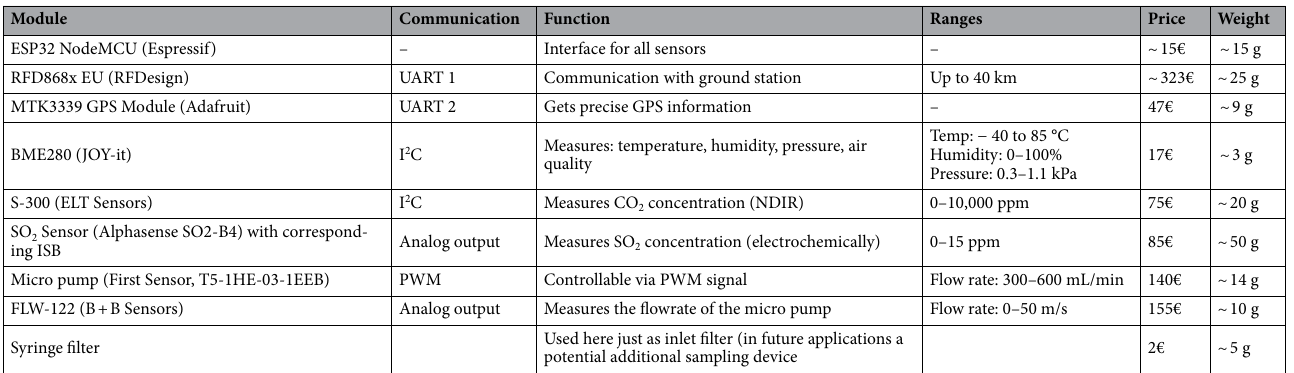
Table 1. Parts list of the sensor system with type of data transmission, function, range of the individual components, weight and approximate